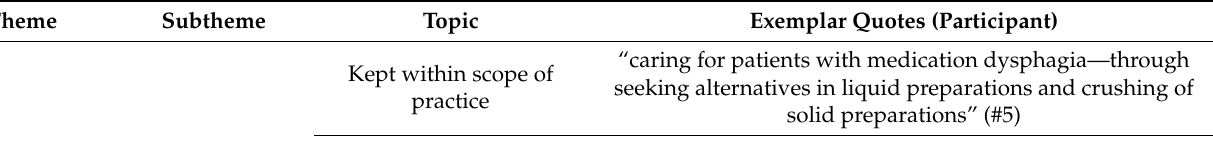
Table 6. Major theme of professional roles, corresponding subthemes, and exemplar